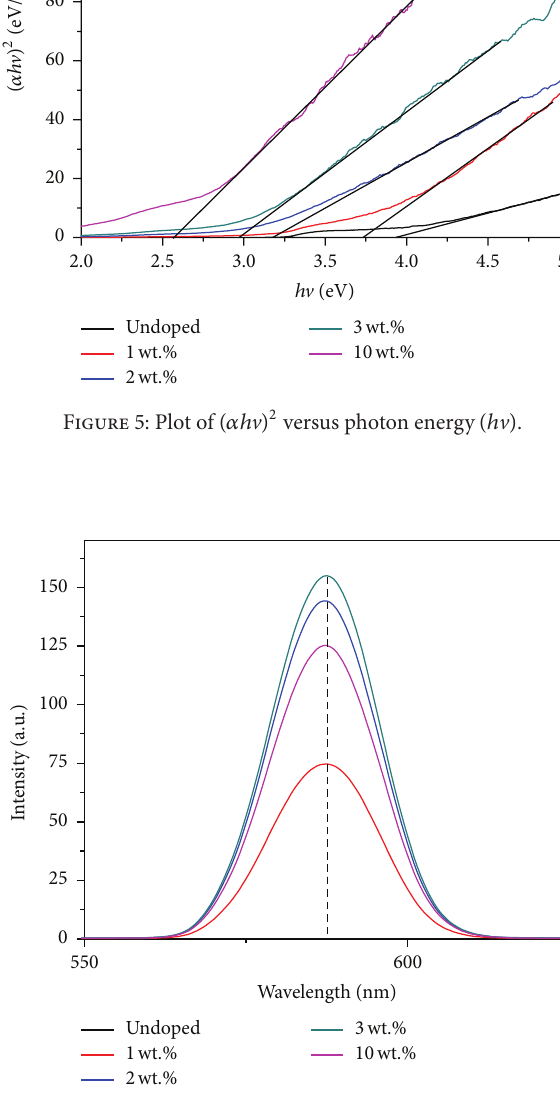
and formation of 𝛽 -Zn 2 SiO 4 , ZnO, and SiO 2 crystal. Inves- tigations of optical band gap show that 𝐸 𝑔 decreased from 3.962 eV to 2.573 eV as we move towards higher concen- tration of MnO. The emission wavelength was obtained at 585 nm which is attributed to yellow emission. The emission intensity amplified as the dopant concentration increased to 3 wt.% and decreased at 10 wt.% of dopant concentration due to the concentration quenching